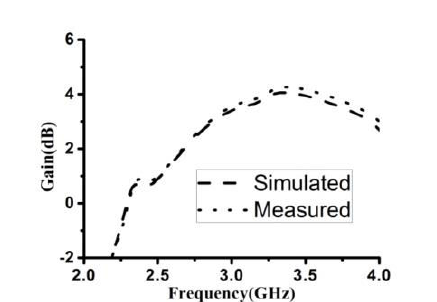
Figure 13: Gain characteristics of the proposed antenna Table 3 gives the comparison between the results of the proposed antenna and the antennas which already exist in the literature. The proposed antenna is more compact and producing wide bandwidth compared to remaining antennas listed in Table 3.